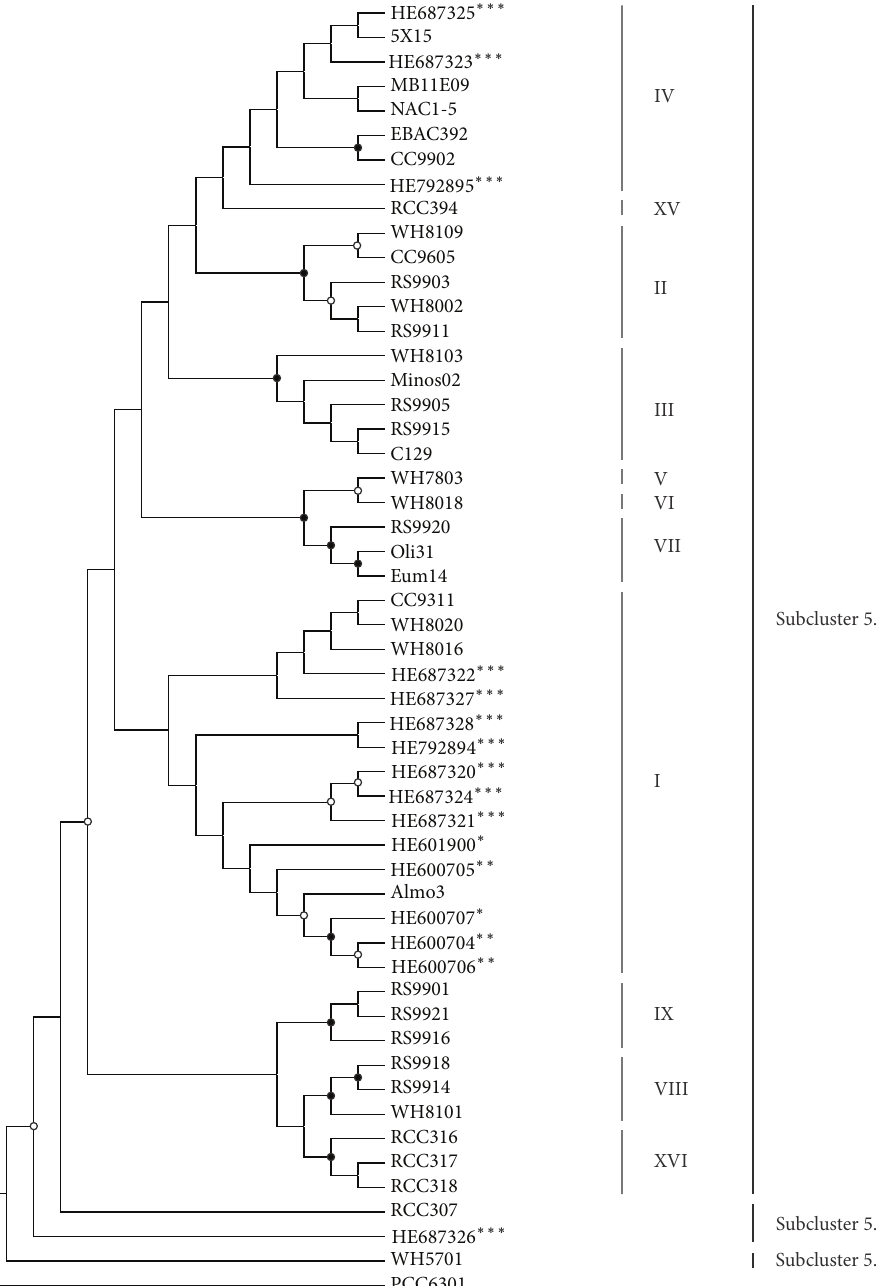
Figure 3: Neighbor-joining phylogenetic trees based on 16S rRNA gene sequences. Bootstrap values were obtained through 1,000 repetitions. Similartreetopologieswereobservedbymaximumparsimonyanalyses(notshown).( ∙ )indicatesavalue > 90%and( ∘ )indicatesavalue > 60%. The freshwater strain Synechococcus sp. PCC 6301 was used as outgroup. Synechococcus clades are marked with roman numbers. Sequences from Synechococcus isolates from environmental samples and from DGGE bands are indicated with one, two, or three asterisks,